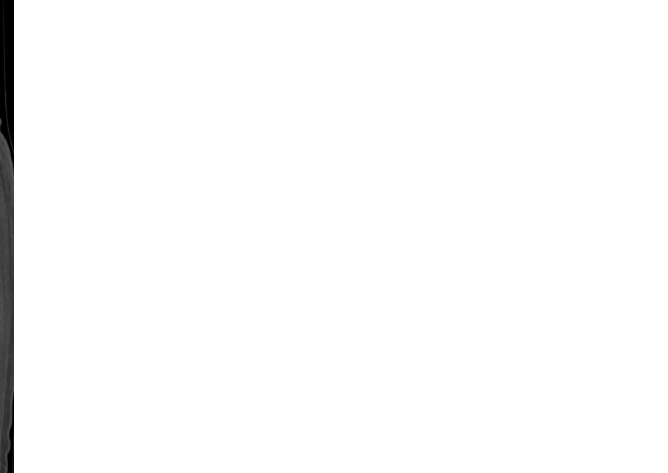
Figure 10. A sagittal CT reconstruction of the cervical and thoracic spine of a 60-year-old patient. There are thick-flowing osteophytes on the cervical spine (arrows), while thin slender vertical syn- desmophytes (arrowheads) are in the thoracic